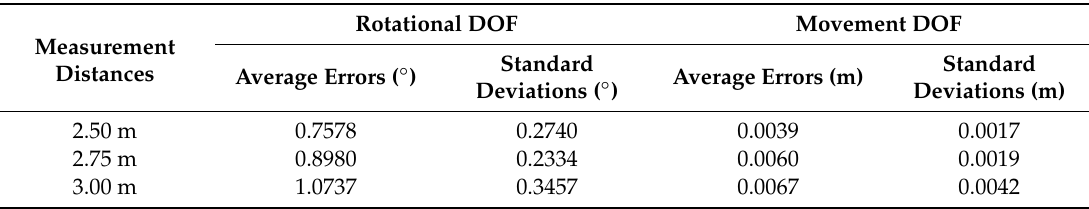
Table 7. Measurement errors and standard deviations at di ff erent measurement distances.